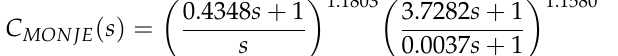
Figure 21. RDR vs. 𝜆 for an integrating time delay process.